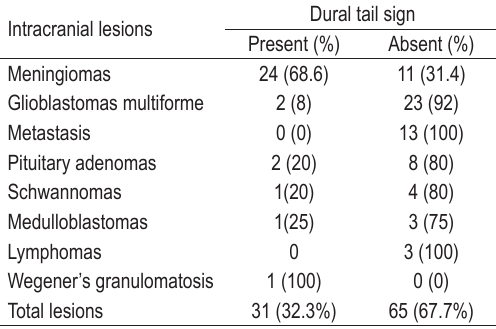
TABLE 1. Presence of the dural tail sign in different intracra-